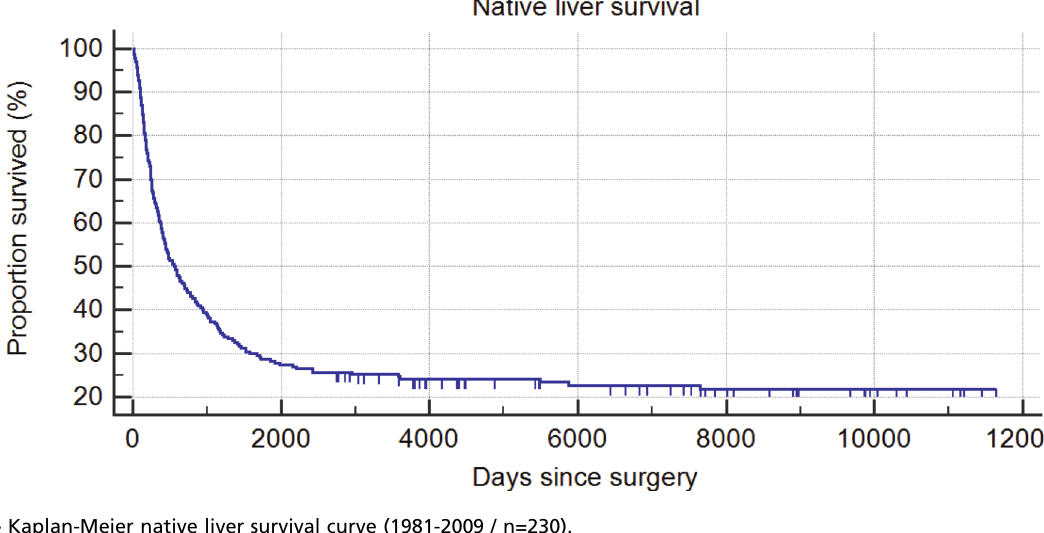
Figure 3 - Kaplan-Meier native liver survival curve (1981-2009 / n=230).